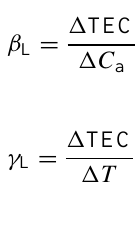
Fig. 3. Total Ecosystem Carbon (TEC) changes relative to the con- trol simulation (1N) in the three sets of simulations. Blue line shows effect of increased N deposition. Green line shows effect of both doubled atmospheric CO 2 content and added N deposition. Brown line shows effect of both 2K warming and added N deposition. The effect of an eight-fold increase in N deposition is approximately the same magnitude but opposite in sign to that of a 2K